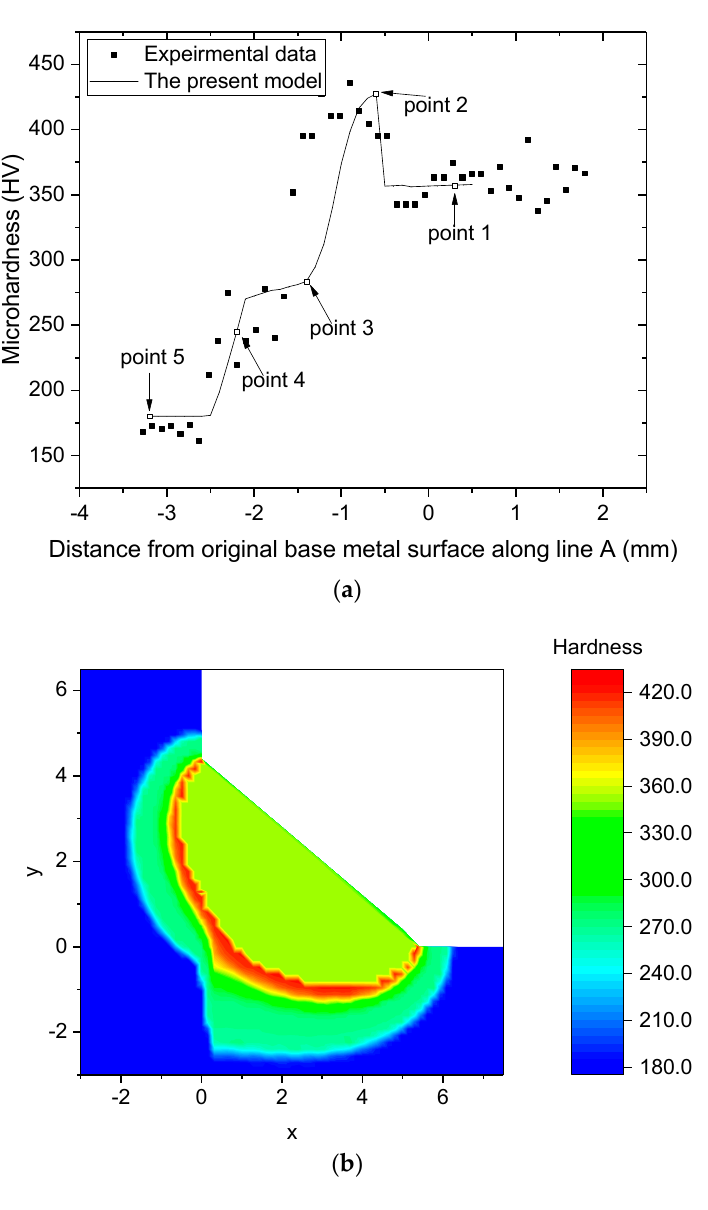
Figure 16. Microhardness ( a ) comparison between predicted and experimental results along the line A in Figure 4, and ( b ) mapping of the